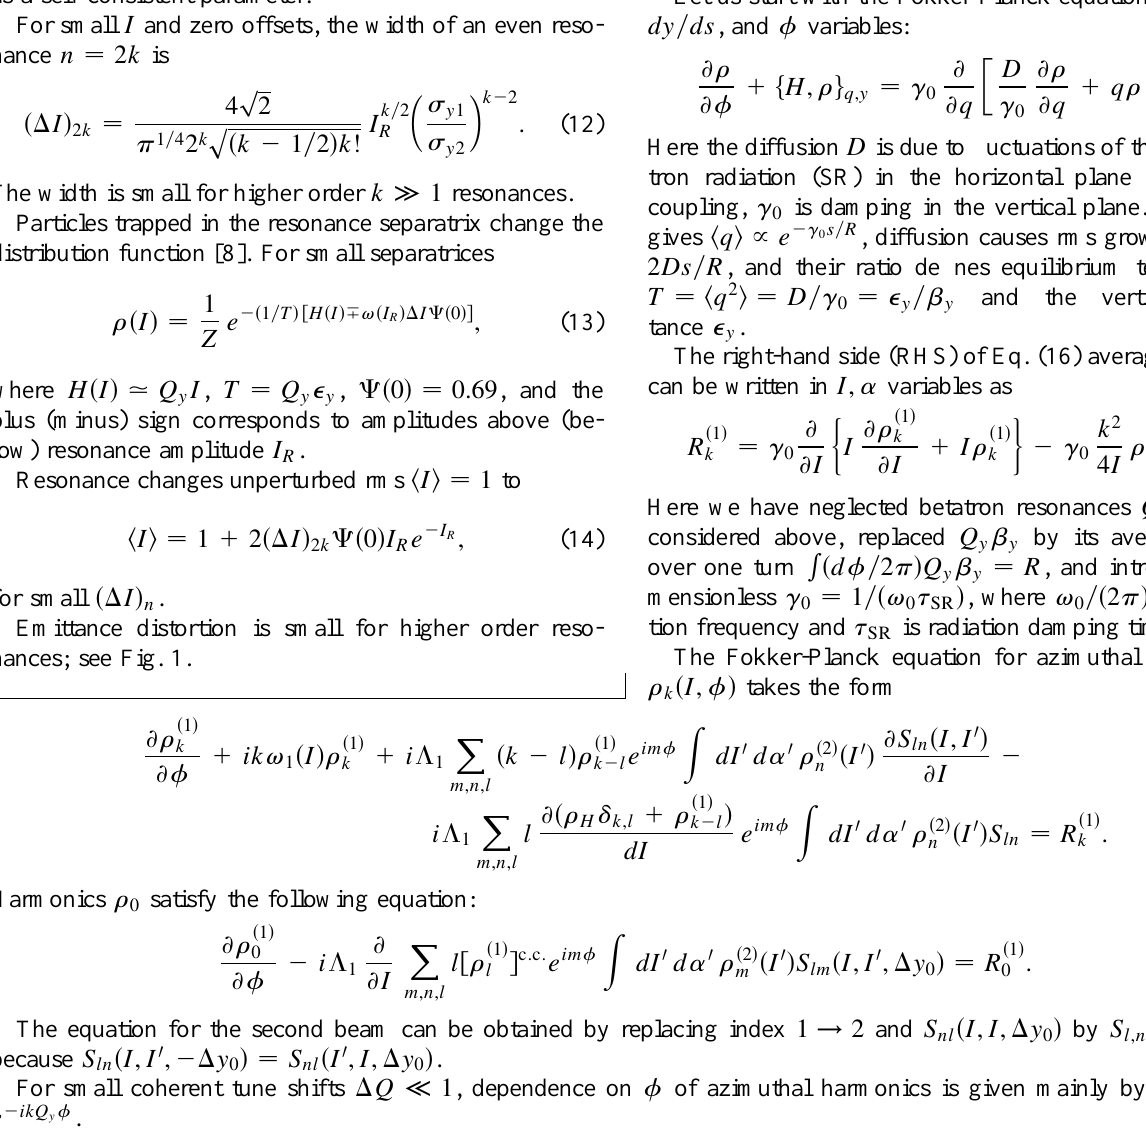
FIG. 1. Distortion of the beam emittance D I due to n (cid:1) 2 k -order resonance vs detuning from the resonance. order of 1, the rms s y defining U n , m has to be understood as a self-consistent